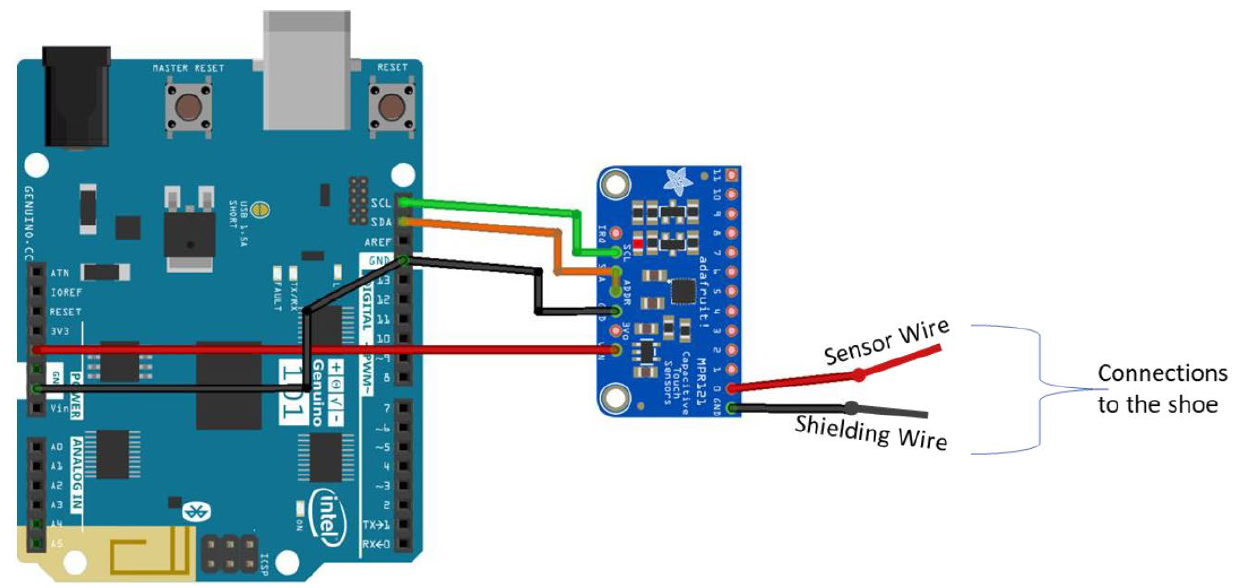
Figure 7. Connections between Arduino 101 and Adafruit MPR121.